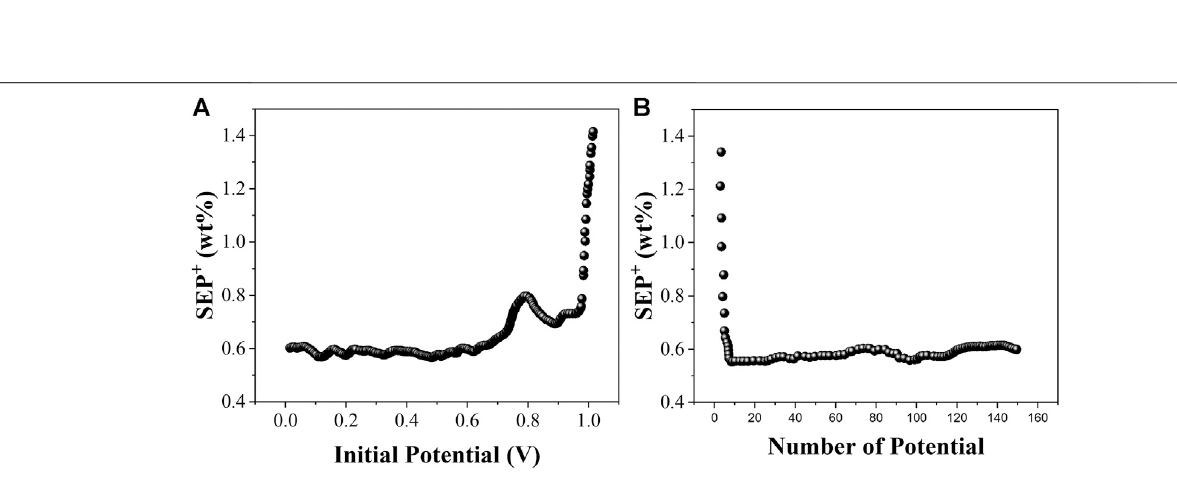
FIGURE 4 | The optimal SEP + corresponding to the starting potential I and the number of potentials N of the soil EC-PLS model for A location.